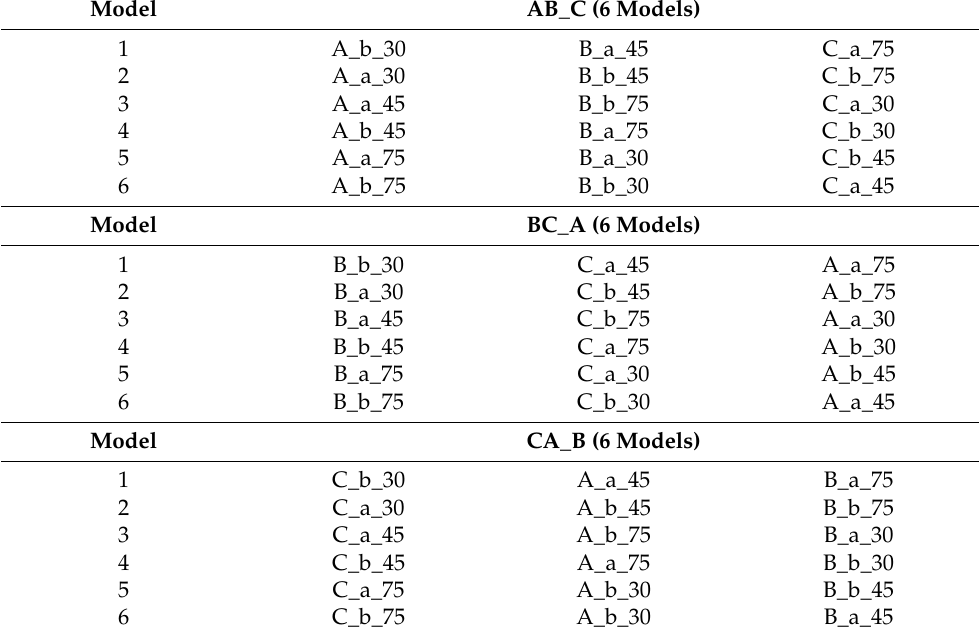
Table 6. Classification of sEMG